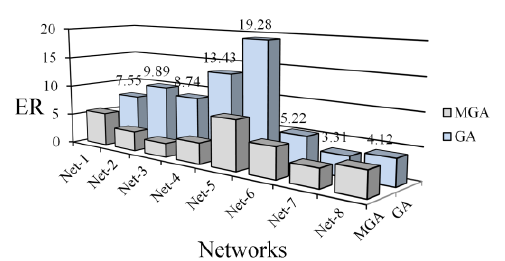
Figure 6. Quality assessment of MGA-FSPP and GA-FSPP based on different random networks